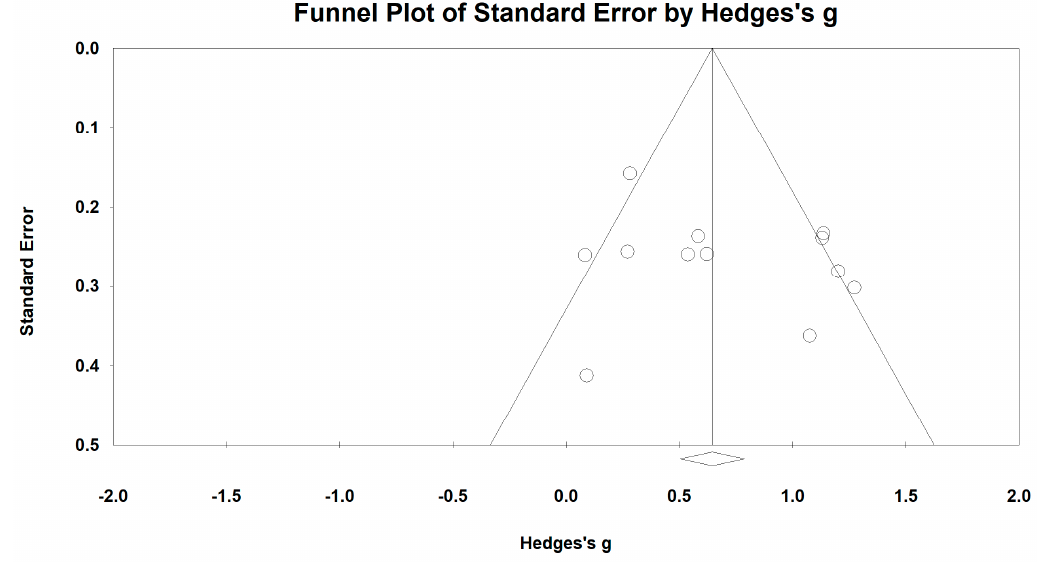
Figure 2. Funnel plot of publication bias for the 6-Minute Distance Test.